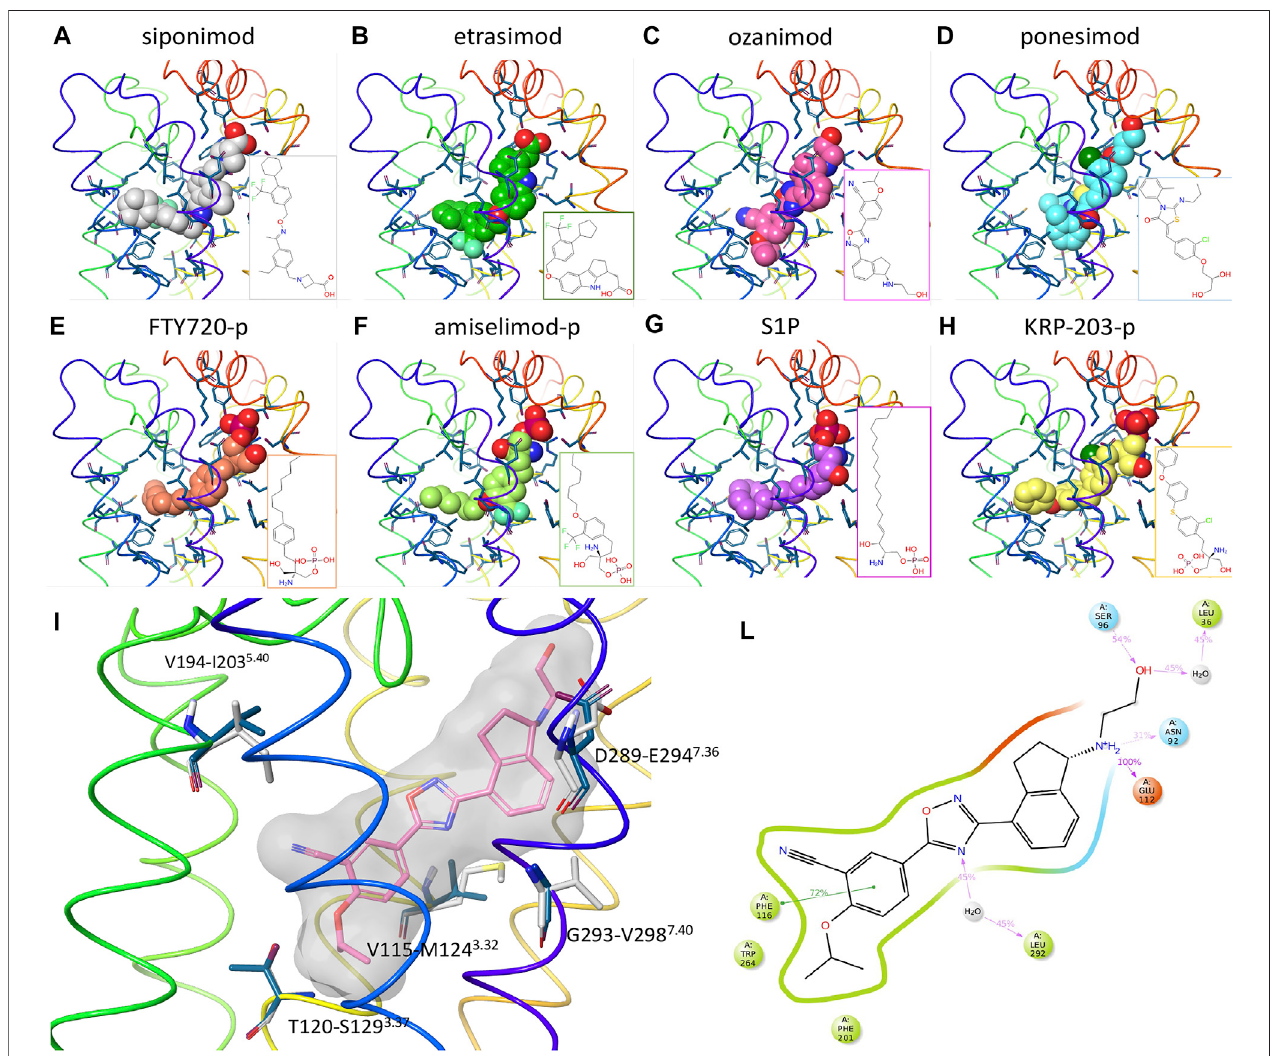
FIGURE3 | Computational chemistry analysis. (A – H): Predicted binding mode toS1P 5 ofsiponimod (A) , etrasimod (B) , ozanimod (C) , ponesimod (D) , FTY720-p (E) ,amiselimod-p (F) ,S1P (G) ,andKRP-203-p (H) .Ligandsareincludedusingthespace- fi llingrepresentation,andtheorthostericresiduesareshownasstickswiththe backboneasathintubecoloredfromred (Nterminus)topurple(Cterminus).Small-moleculetwo-dimensional(2D)structures areincluded inthebottomrightpart ofthe panels. (I) Predicteddockedposeofozanimodshownasstickswithpinkcarbonatomsandagreytransparentmolecularsurface.Residuesclosetotheligandand different between S1P 5 (dark blue) and S1P 1 (white) are included and labeled with the S1P 5 residue numbers, followed by the S1P 1 and family A G protein – coupled receptorgenericnumbering insuperscript(Isberget al.,2015). (L): 2Drepresentation ofozanimod andcloseresiduesinteractingwiththeligandduringtheabsolutefree energy perturbation molecular dynamics (MD) simulation. Hydrophobic, polar, and negatively charged amino acids are shown in green, cyan, and red, respectively. Hydrogen bonds and ionic interactions are shown as magenta lines and π − π interactions as green lines. The amount of time in which the interactions are created during the MD simulation is shown as a percentage of the total simulation length (5 ns). S1P, sphingosine 1-phosphate; S1P 5 , sphingosine 1-phosphate receptor subtype 5.